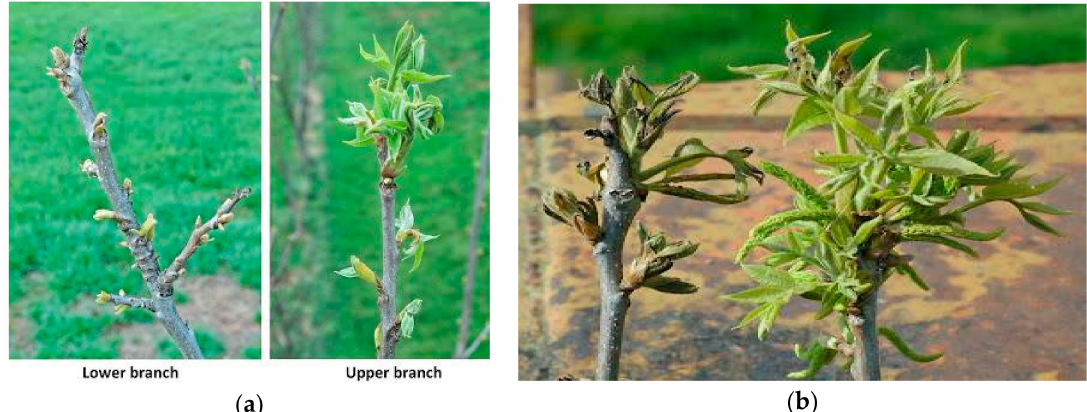
Figure 4. E ff ect of radiation freeze (on 16 April 2018) on bud break within same tree: ( a ) In the lower portion of the canopy (left) and higher (right) [43,51]. ( b ) A branch only 2.4 m above the ground (leaf side) and shoot from a limb 6.1 m from the ground with healthy catkins (right side) (after 18 April 2020 freeze) [37].